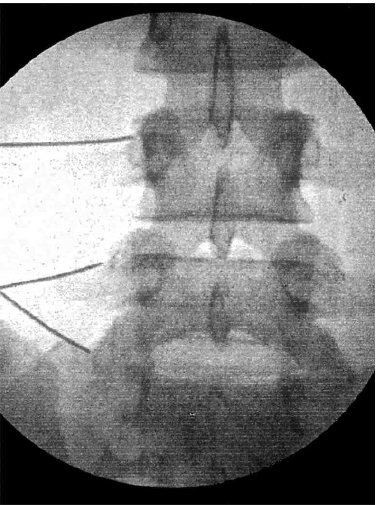
Figure 1 - A radiograph in the anterior-posterior view during the controlled medial branch block procedure in one patient, with needles positioned in the medial branches of L3, L4 and L5